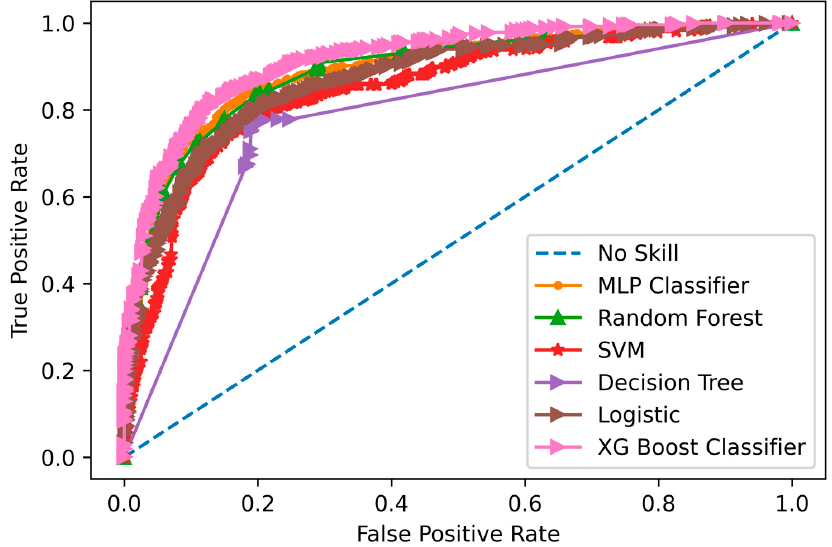
Figure 5. Image 3A indicates the AUC curve of different ML models generated using scikit-learn. The XG model indicated in pink had the highest area in the ROC curve.